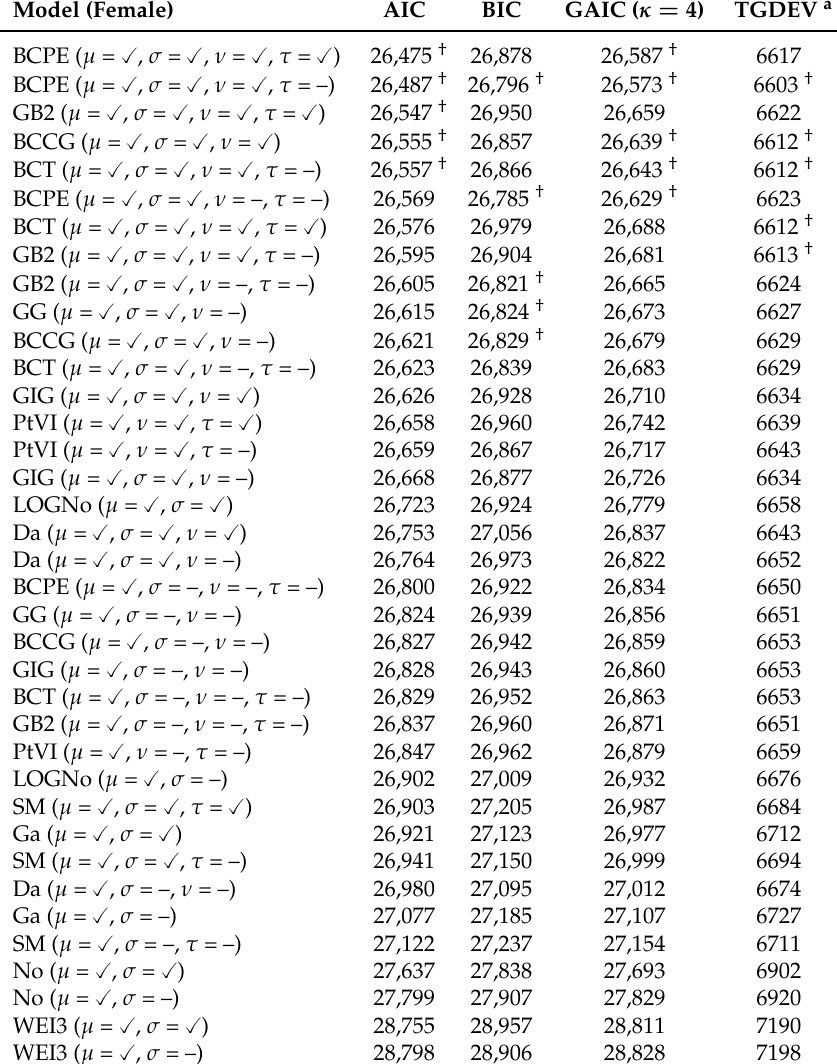
Table A3. Information criteria of estimated models with the female